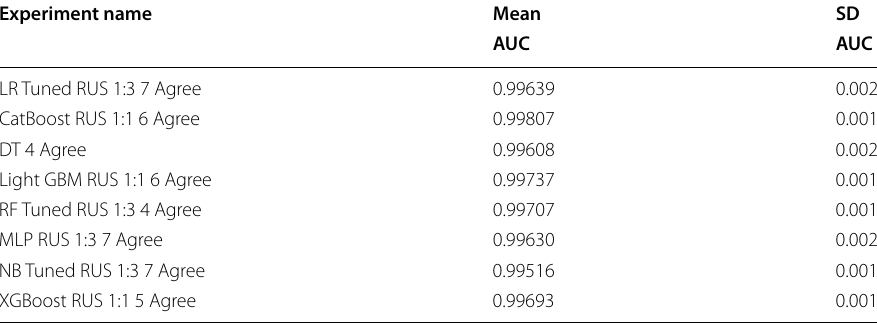
Table 35 Maximum AUC by classifier for the keylogging attack type; mean and standard deviations of AUC, (10 iterations of 5-fold cross-validation)